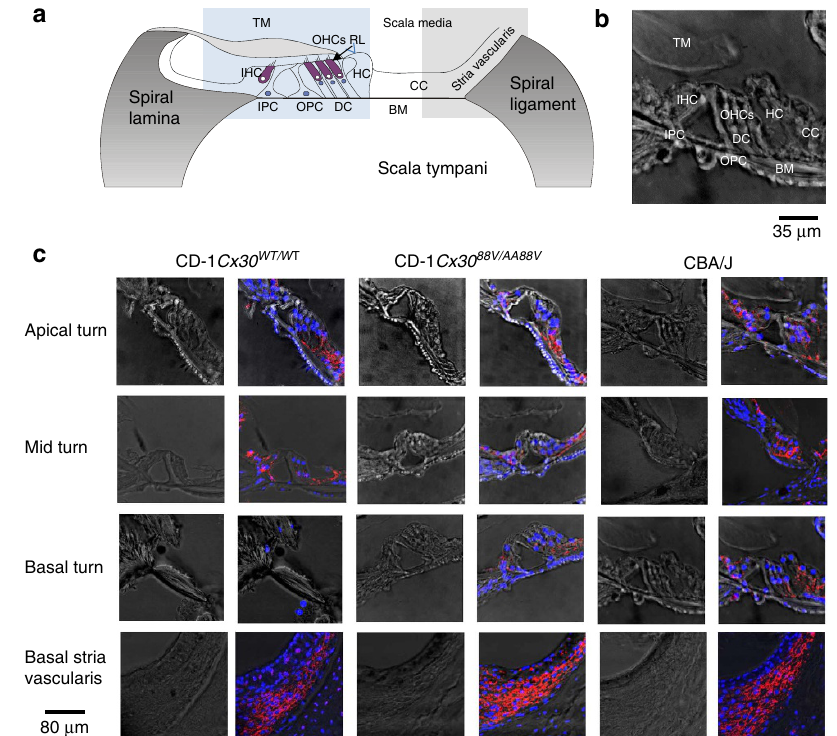
Figure 1 | Cx30 immunoreactivity in cochleae of CBA/J and CD-1 Cx30 A88V/A88V mice are similar. ( a ) Schematic cross-section of the cochlea showing cells of the sensory epithelium (organ of Corti) including inner pillar cells (IPCs), outer pillar cells (OPCs), Deiters’ cells (DCs), Hensen cell (HC), outer hair cell (OHC), inner hair cell (IHC), Claudius cells (CCs) and major non-cellular elements (basilar membrane (BM), tectorial membrane (TM) and reticular laminar (RL); modified with permission from Fig. 1 (ref. 49). ( b ) Confocal micrograph of 10 m m cryosection taken from middle turn of cochlea in c to identify details of cells and noncellular structures in the organ of Corti. Modified from c . Rows of confocal micrographs of 10 m m cryosections of the apical, middle and basal turns of the organ of Corti and stria vascularis. The rows are organized in columns of pairs of micrographs at each location from CD-1Cx30 WT/WT , CD-1 Cx30 A88V/A88V and CBA/J mice. The left of each pair of micrographs shows the unstained section. In the right of each pair, the Cx30 (red) expression is revealed with a selective antibody and nuclei are counterstained with DAPI (blue). OHCs, DCs and spiral lamina cells are intact in all cochlea turns of CBA/J and CD-1 Cx30 A88V/A88V mice but not in the basal turn of CD-1 Cx30 WT/WT mice. Cx30 appears to be localized in the